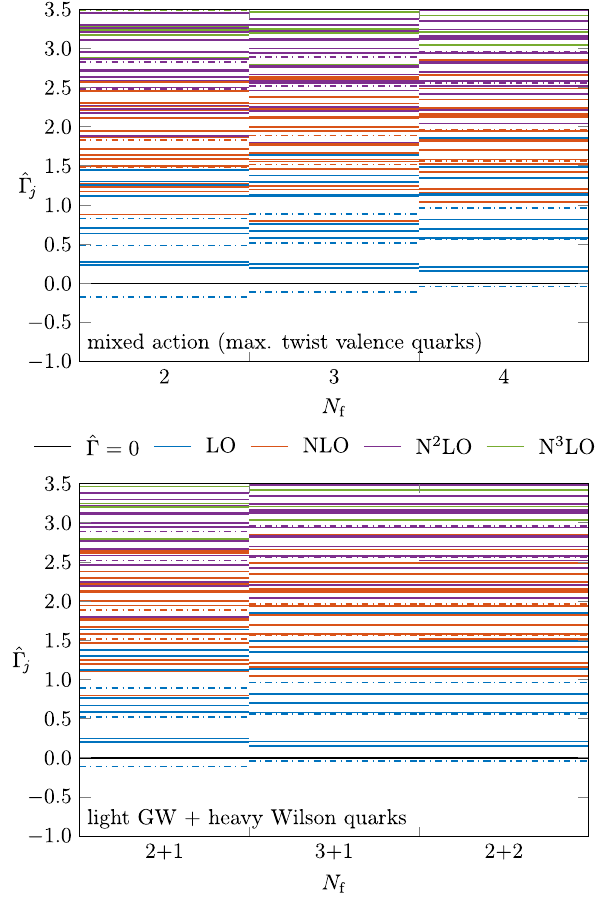
Fig. 5 Leading and subleading powers in the coupling ˆ (cid:2) j for the min- imal on-shell operator basis describing the leading order lattice artifacts for spectral quantities at N f = 2 , 3 , 4. Here two distinct sets of flavours are assumed either in a mixed action with the setup described in [61] or using different lattice discretisations for light and heavy quarks, here GW and Wilson quarks respectively. While the solid lines correspond to the massless operator basis (possibly containing massive mixing contri- butions),thedash-dottedlinesbelongtotheoperatorswithoverallmass- dependence. In case the tree-level coefficient vanishes, the first power plotted is regarded as NLO in the colour coding. Due to overlapping numerical values leading powers may be hidden by the “subleading” powers of other